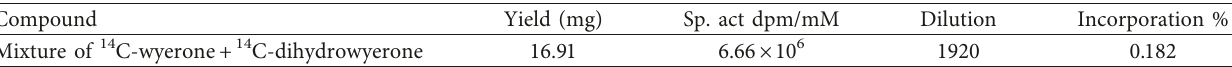
Table 1: Mean radioactivity measurement of 14 C-labelled wyerone and 14 C-dihydrowyerone mixture from feeding experiments with sodium (2- 14 C) acetate. The results are average of two trials.